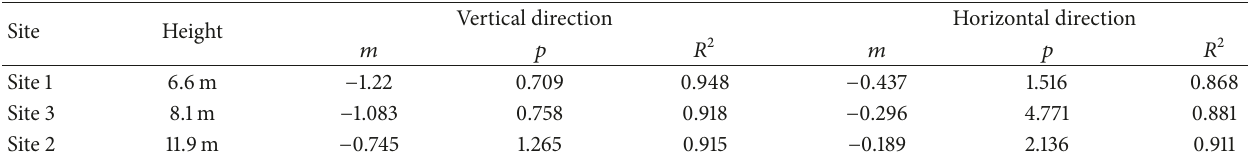
Table 2: Site attenuation